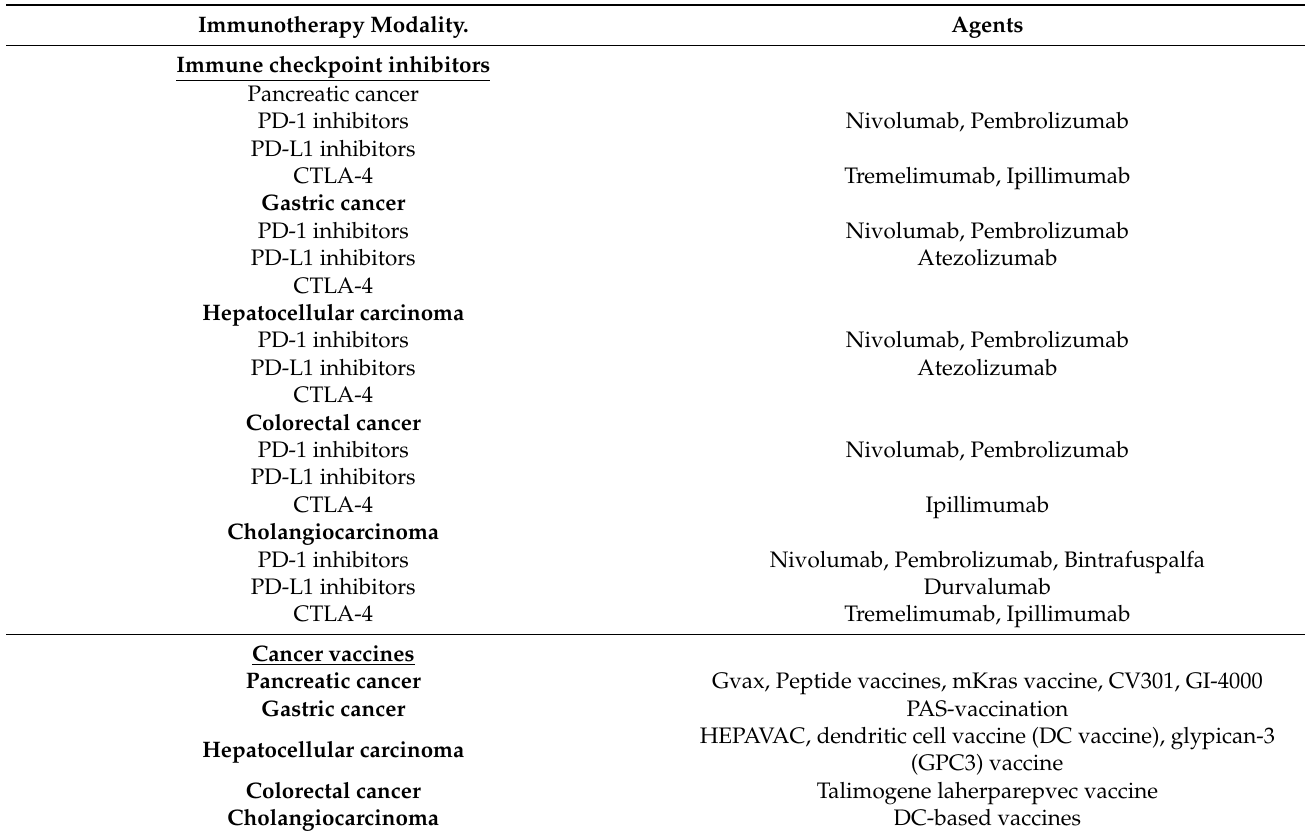
Table 3. Summary of immunotherapy for gastrointestinal cancers. Immunotherapy